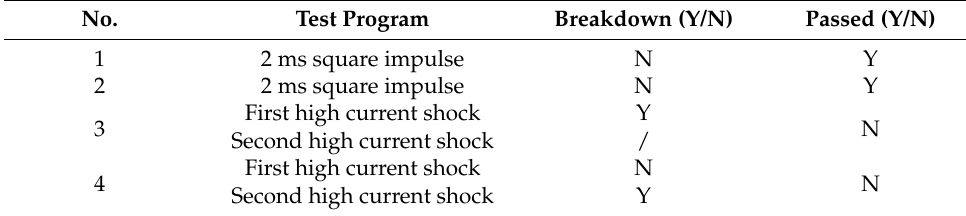
Table 4. Current withstand test of a defective varistor.